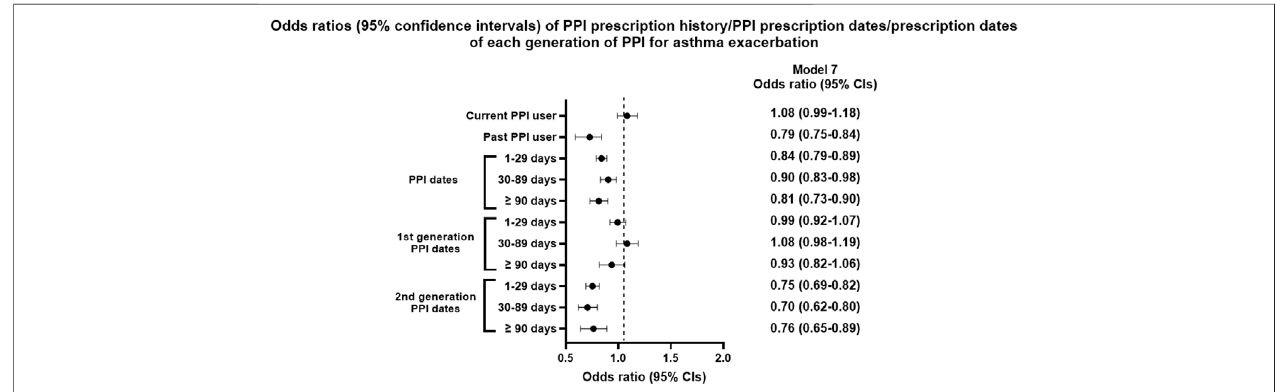
FIGURE 3 | Odds ratios (95% con fi dence intervals) of PPI prescription history/PPI prescription dates/prescription dates of each generation of PPI for asthma exacerbation.